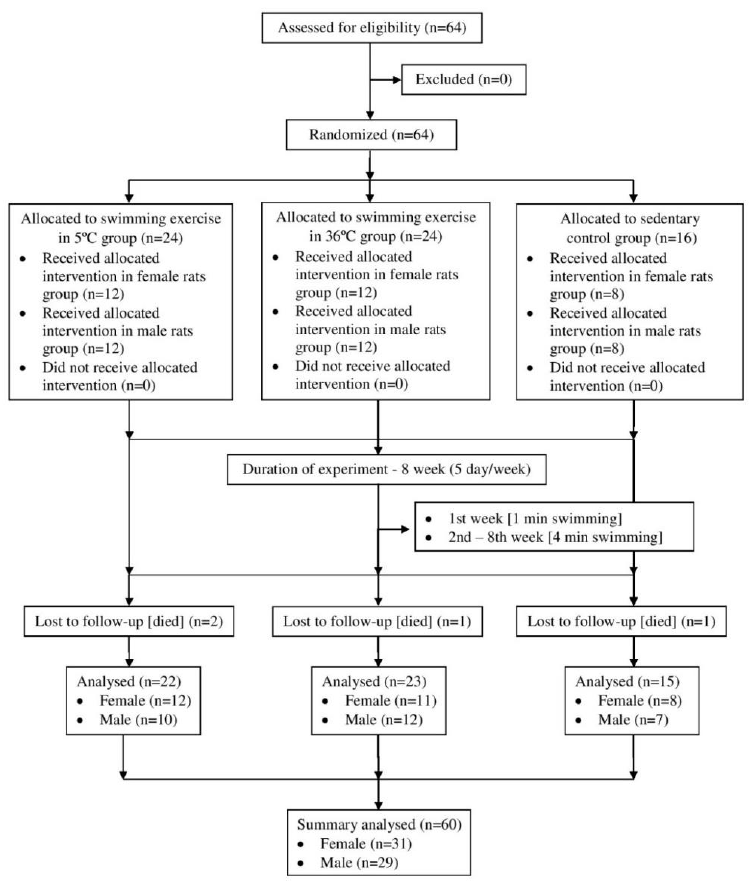
Figure 1. Protocol of experiment.